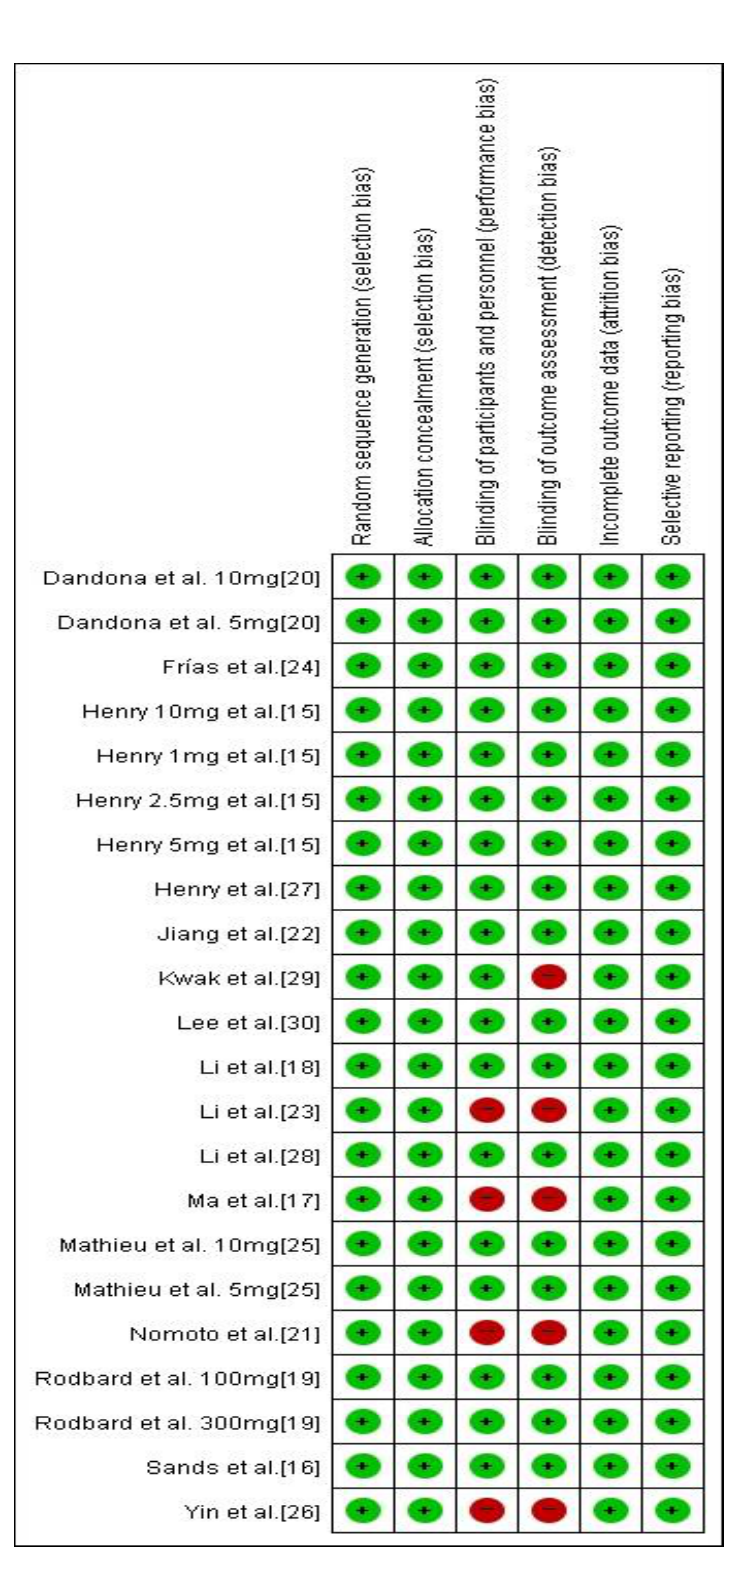
Figure 8. Risk of bias assessment of the studies included in the analysis.